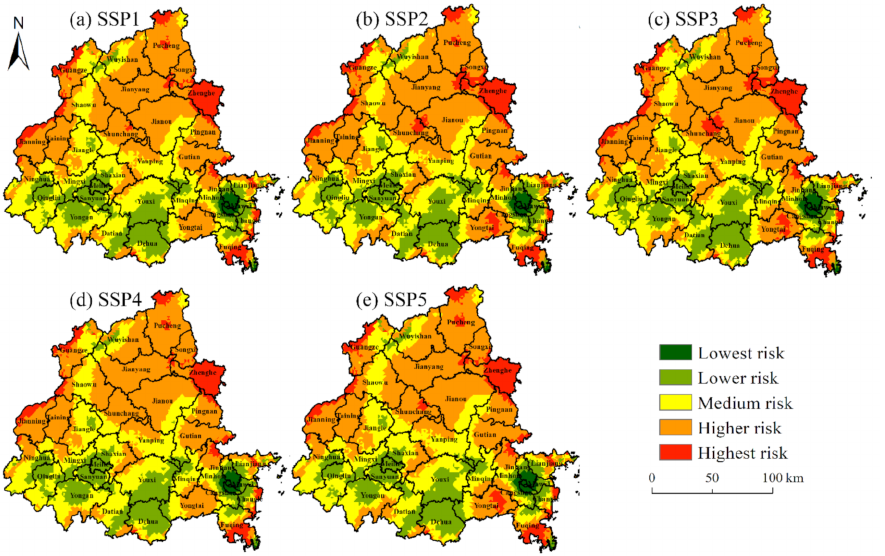
Figure 4. ( a – e ) Spatial distribution of landscape ecological risk in 2030 under SSPs scenario. Notes: ( a ) SSP1 scenario; ( b ) SSP2 scenario; ( c ) SSP3 scenario; ( d ) SSP4 scenario; ( e ) SSP5